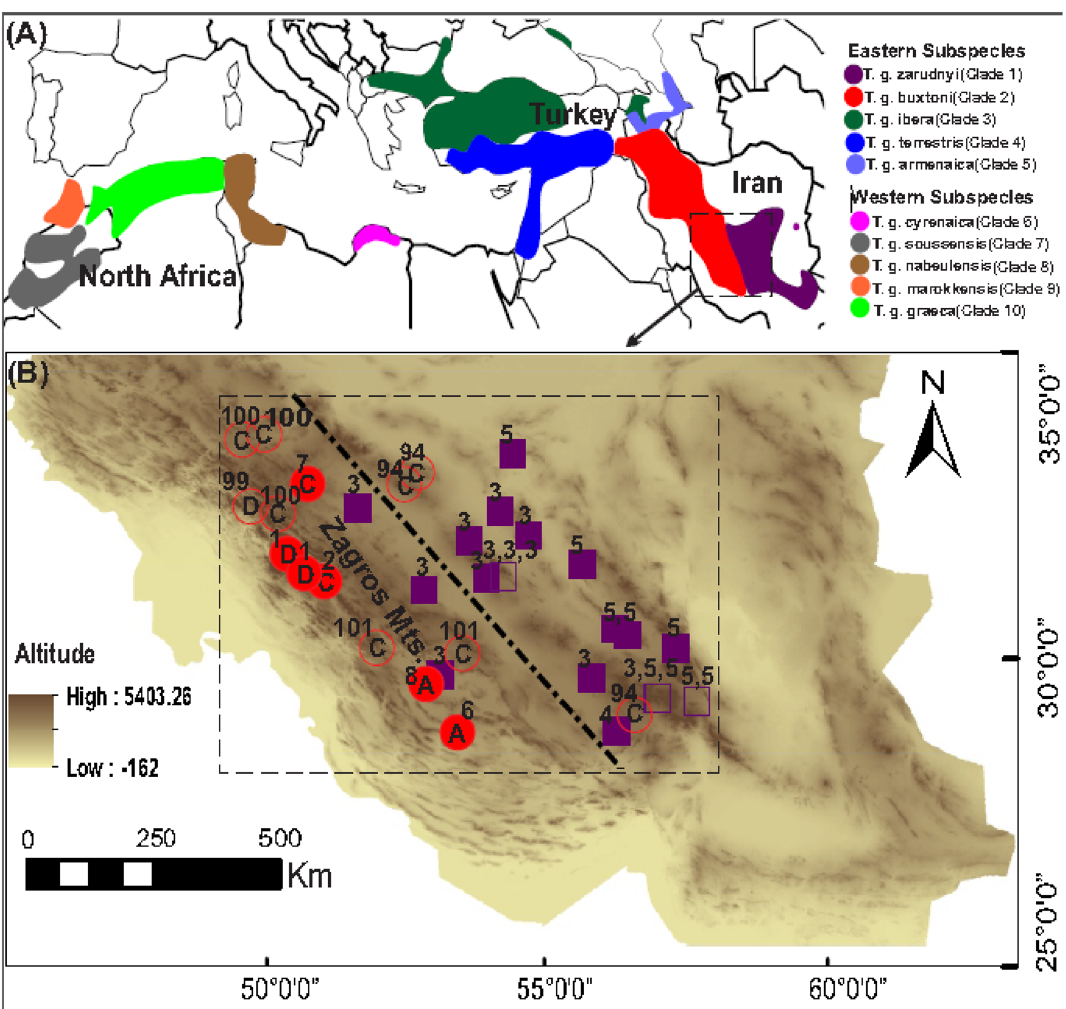
Figure 1. ( A ) The approximate distribution of spur-thighed tortoise’s ( Testudo graeca ) subspecies according to Graciá et al. 10,28 , Turkozan et al. 9 , and Javanbakht et al. 7 . ( B ) Geographical distribution of the sampling sites of the spur-thighed tortoise in the contact zone between two subspecies T. g. zarudnyi (Clade 1) and T. g. buxtoni (Clade 2) in Central Iran. Purple squares and red circles indicate clades 1 and 2, respectively, and the numbers next to the symbols indicate the haplotypes detected in each sampling sites, according to the numbering assigned to them (see Figs. 2, 3 for details). A, C, and D, denote three subclades found in clade 2 from the study area. Outlined symbols show the sampling sites of the species in Javanbakht et al. 7 . The dashed line refers to the approximate position of the contact zone between the two clades. The base map was obtained from OpenStreetMap contributors, available under Open Data Commons Open Database License (www. opens treet map. org/ copyr ight) and developed in ArcGIS